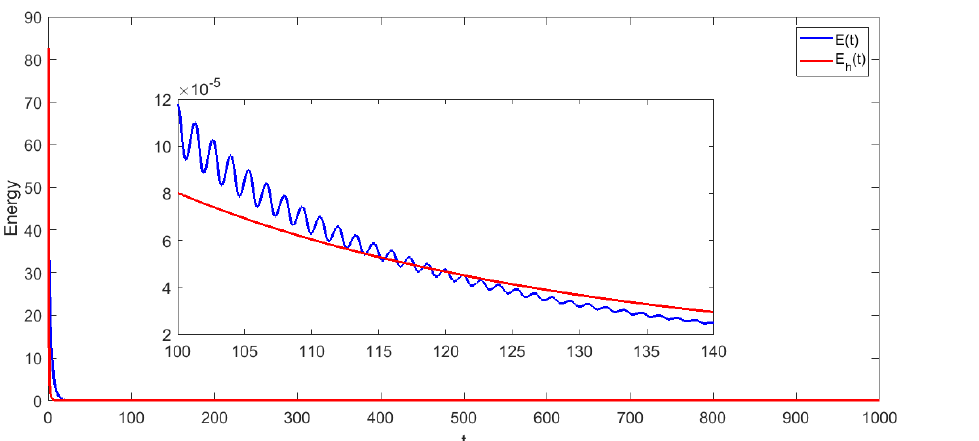
Figure 6. Test 3: energy